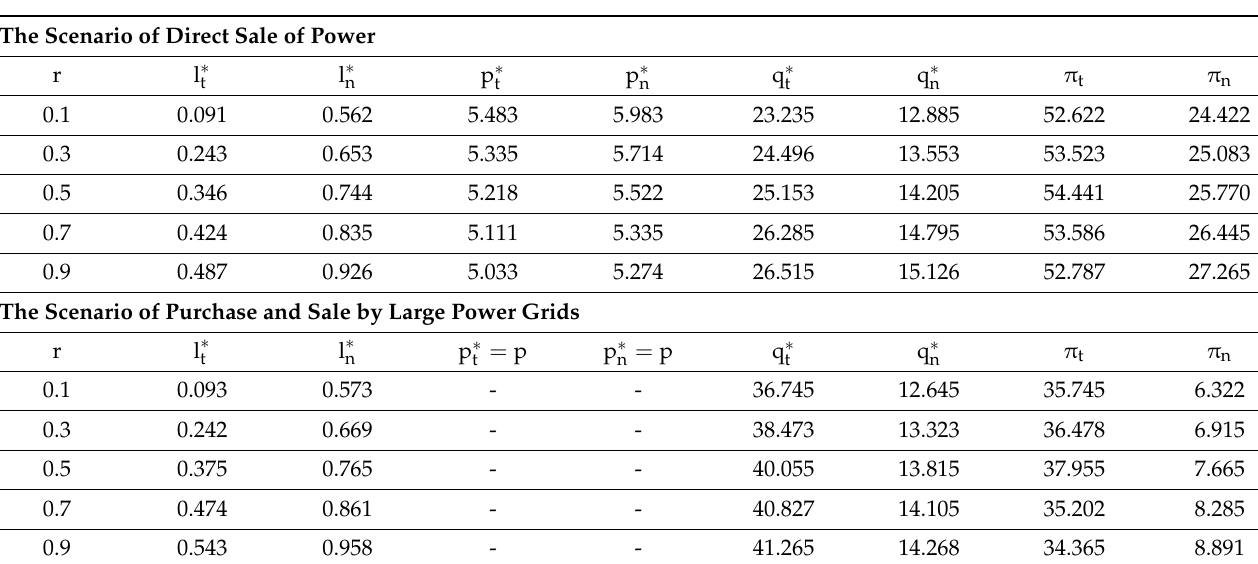
Table 1. Impact of quota on the investment and production of renewable energy.